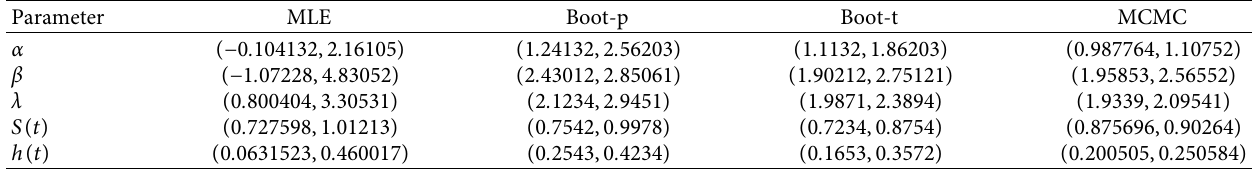
Table 3: 95% CIs of α , β , λ ,S ( t ) and h ( t ) .